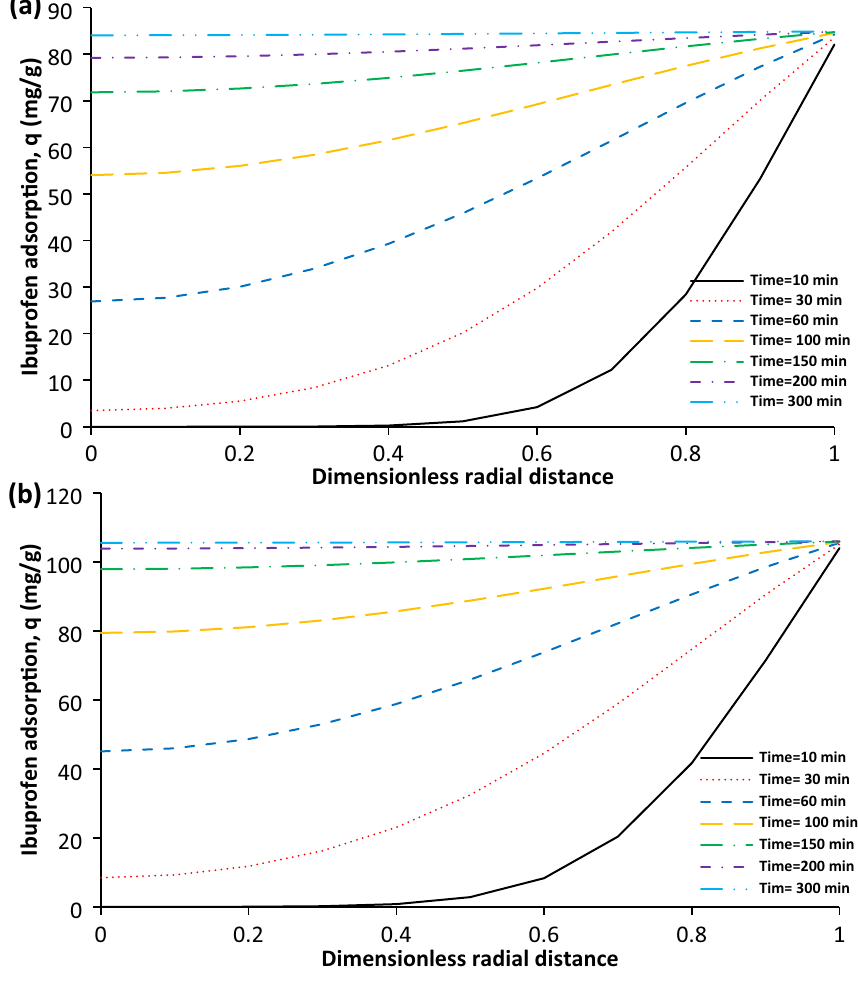
Figure 3. The ibuprofen adsorption as function of dimensionless radial distance at different times for AC ( a ) and SAC ( b ), initial ibuprofen concentration = 100 mg/L, T = 298 K, pH = 2, AC porosity = 0.392, SAC porosity = 0.474, adsorbent dosage of 0.5 g/L, and particle radius = 163